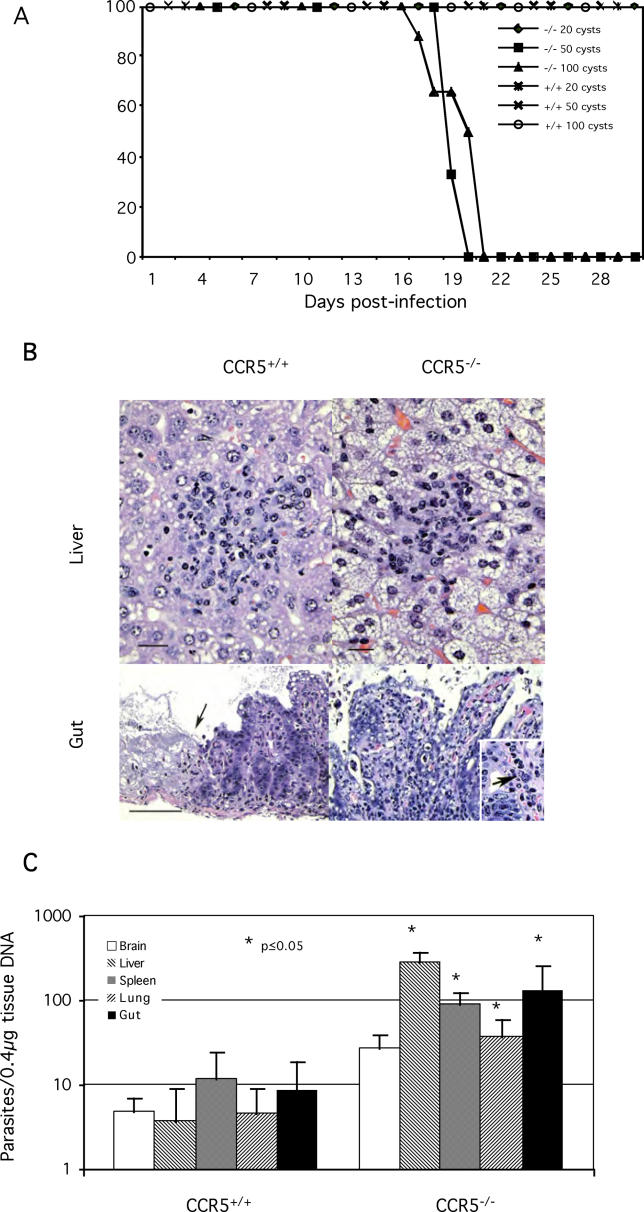
Survival, Histopathology, and Parasite Load of CCR5−/− and CCR5+/+ Mice in a C57BL/6x129 Background following Infection with Different Doses of T. gondii
(A) Survival. Female CCR5−/− mice (5–8 wk old) and age-matched CCR5−/− wild-type littermate controls, both in a C57BL/6x129 background, were challenged perorally with the cysts of the 76K strain of T. gondii. The animals were monitored for survival on daily basis. There were six animals per group and the experiment was performed three times with similar results. All CCR5+/+ mice survived at the three doses of cysts tested.(B) Histopathology. Photomicrographs of hematoxylin and eosin-stained liver and ileum of small intestine isolated from infected CCR5+/+ mice and CCR5−/− mice at day 14 PI. Wild-type liver: Moderate fatty change is seen in hepatocytes, with small foci of mixed polymorphonuclear and mononuclear infiltration. Bar, 10 μm. CCR5−/− liver: Severe fatty changes are seen in hepatocytes with mononuclear and polymorphonuclear inflammatory nodules. Bar, 10 μm. Wild-type small intestine: The superficial mucosa is missing in some places (arrow) and no parasite multiplication is evident. Bar, 100 μm. CCR5−/− small intestine. The superficial mucosa is largely missing and a mixed inflammatory infiltrate including polymorphonuclear cells is evident within the lamina propria and superficial mucosa. Bar, 100 μm. Inset: Higher magnification with arrow pointing to tachyzoites in lamina propria of CCR5−/− mice. Bar, 75 μm.(C) Level of parasite DNA. Groups of CCR5−/− mice and wild-type littermate controls both on a C57BL/6x129 background were infected perorally with 20 cysts of T. gondii. At day 14 PI, small intestine, liver, spleen, lung, and brain from both CCR5−/− and wild-type mice (three mice per group) were collected and the parasite load in the tissues was determined by competitive PCR. The experiment was performed twice with similar results.